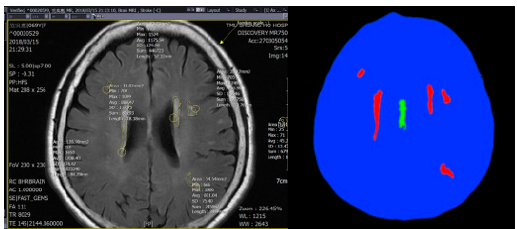
Figure 2. ( Left ) is an image of the area of the cerebral small vessel lesion by the physician, and ( right ) the image marked by the physician as a